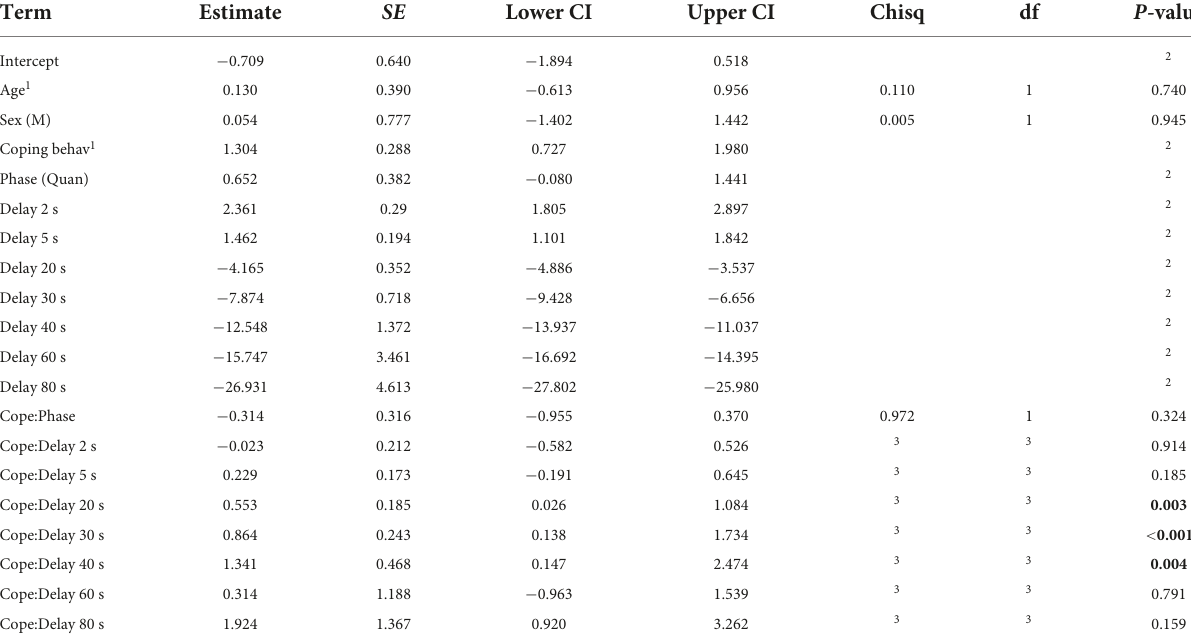
TABLE 5 Effects of age, sex, amount of coping behaviors, test phase and delay on number of successful trials